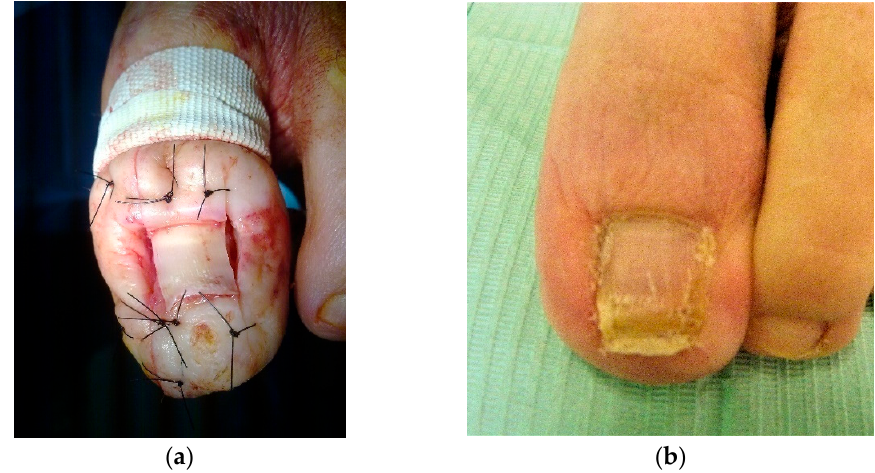
Figure 3. Immediate postoperative appearance ( a ). Aspect of hallux toe at year and a half ( b ).